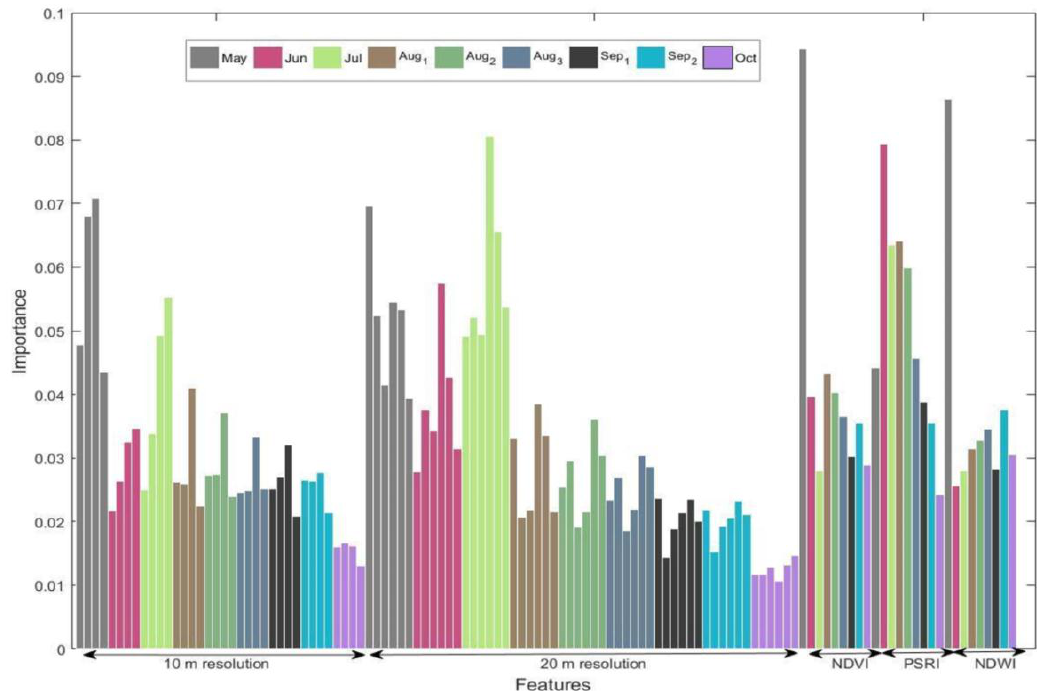
Figure 6. Feature importance bar graph of Sentinel-2 features, for the crop type classification. Features are grouped with respect to their spectral characteristics by position, and to their acquisition dates by color. The order for the 10 m resolution bands is B02-B03-B04-B08 and for the 20 m resolution bands is